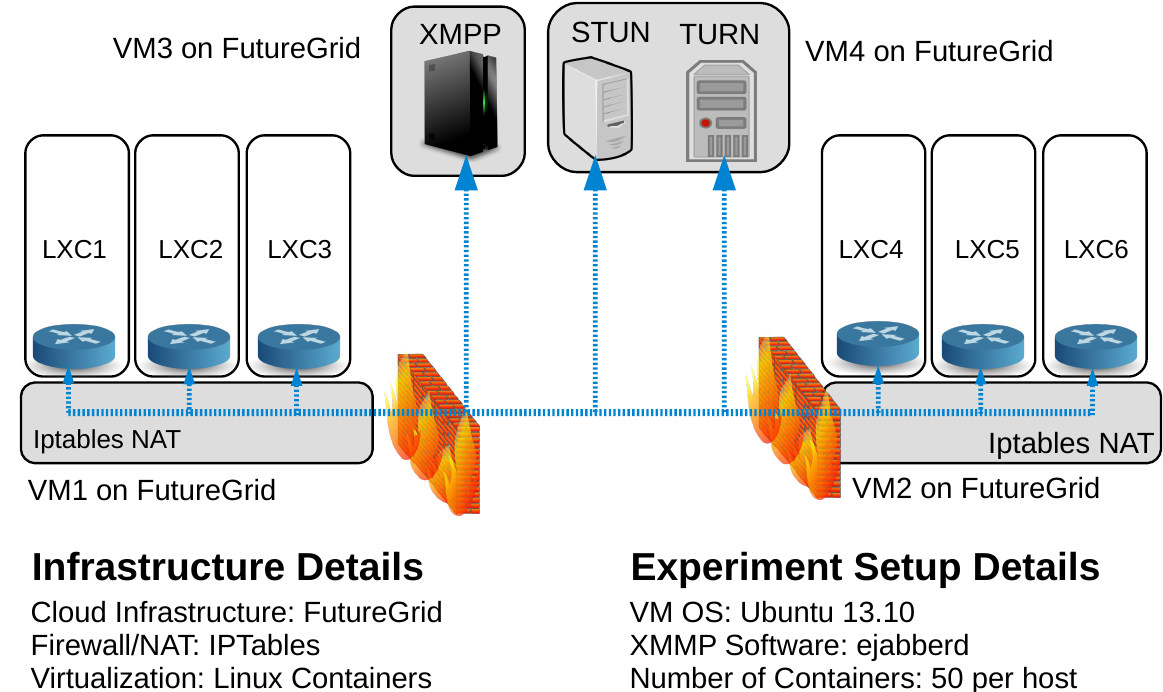
Figure 6. Experimental Setup Details Table 1. Experimental Setup